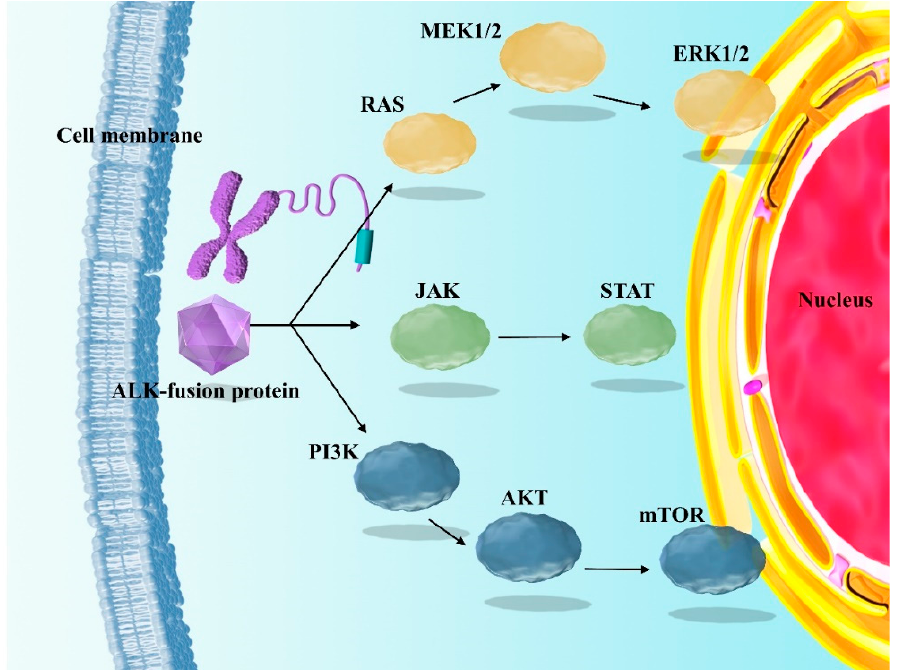
Figure 1. Mechanisms of ALK translocation cancer progression. EML4 ₋ ALK translation triggers the initiation of the PI3K-AKT, RAS, and JAK/STAT signaling cascades that influence tumor growth, proliferation, and viability. ERK, extracellular signal-regulated kinase EML4 ₋ ALK, echinoderm microtubule-associated protein-like 4-anaplastic lymphoma kinase; PI3K, phosphatidylinositol-3 kinase; mTOR, STAT, signal transducer and activator of transcription. ALK, anaplastic lymphoma kinase; mammalian target of rapamycin; JAK, Janus kinase; MEK, mitogen-activated extracellular signal regulated kinase; RAS, reticular activating system.